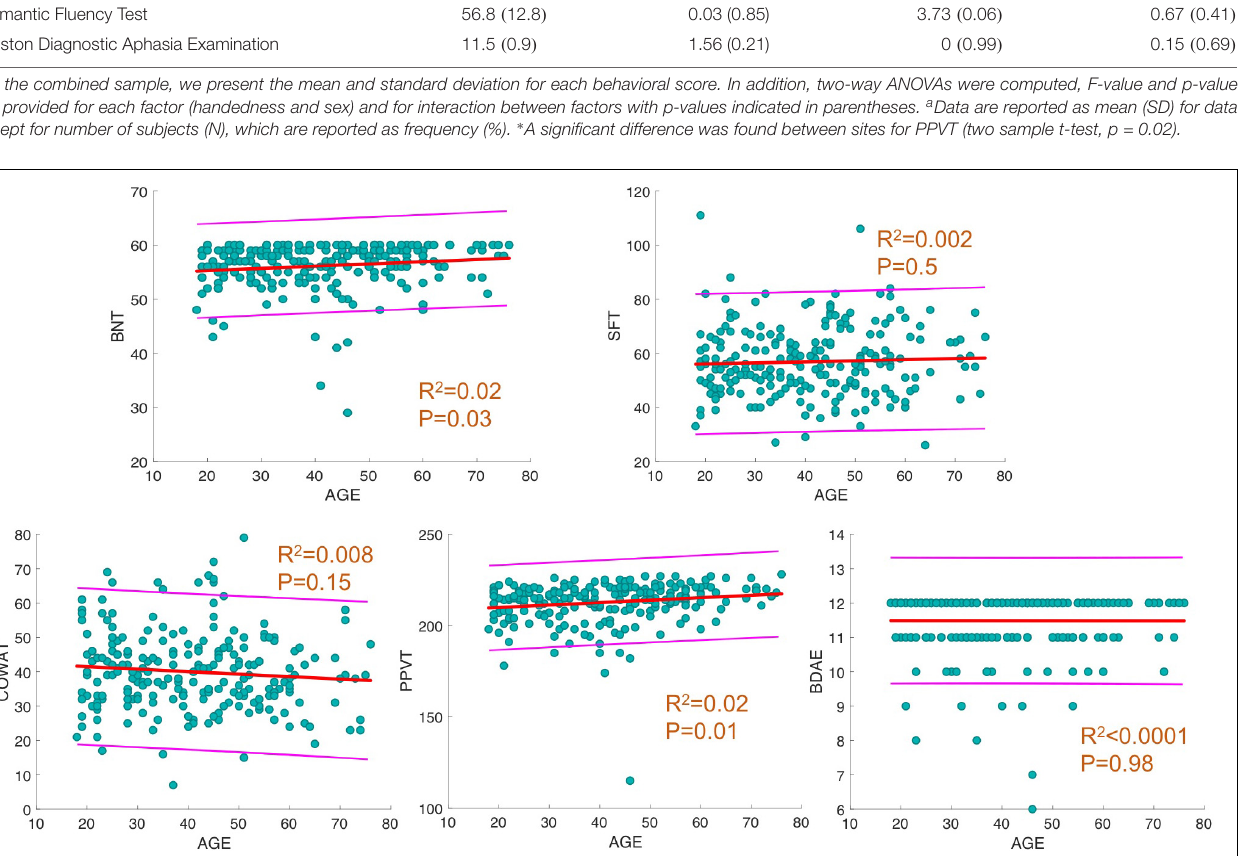
FIGURE 1 | Linear fit between age and behavioral scores. For each behavioral score, linear fit of data with 95% prediction interval is depicted. In addition, R 2 and p -values of regression analysis between age and score is